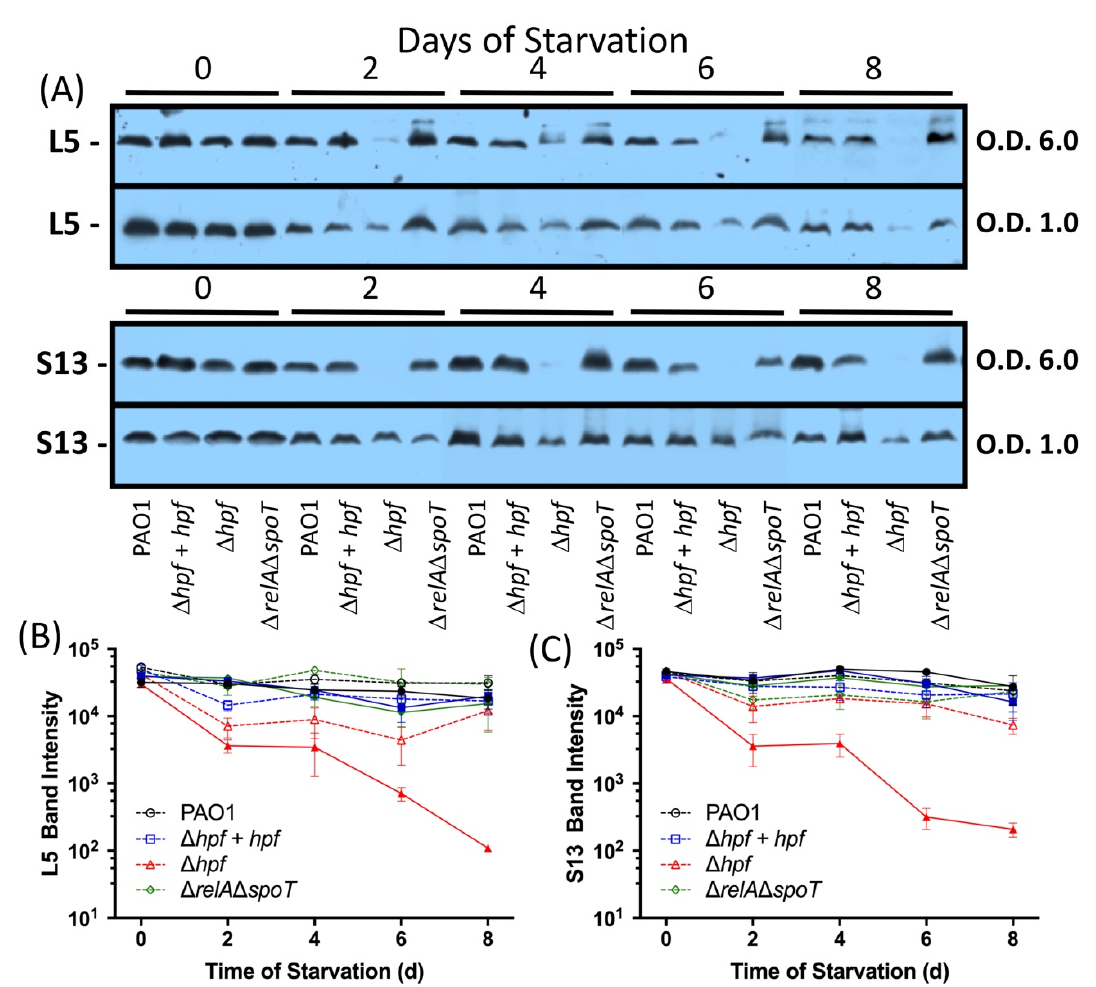
Figure 3. Immunoblot and densitometry analysis of P. aeruginosa L5 and S13 ribosomal proteins over the course of starvation. ( A ) L5 and S13 Immunoblots of P. aeruginosa PAO1, P. aeruginosa ∆ hpf , P. aeruginosa ∆ hpf + hpf and P. aeruginosa ∆ relA ∆ spoT over 8 d of starvation. Strains were pre-cultured to O.D. 600 = 6.0 (filled symbols and solid lines) or O.D. 600 = 1.0 (open symbols and dashed lines) prior to starvation. ( B ) Densitometry of L5 immunoblots showing the mean and standard error of the mean of three replicate immunoblots. ( C ) Densitometry of S13 immunoblots showing the mean and standard error of the mean of three replicate immunoblots.